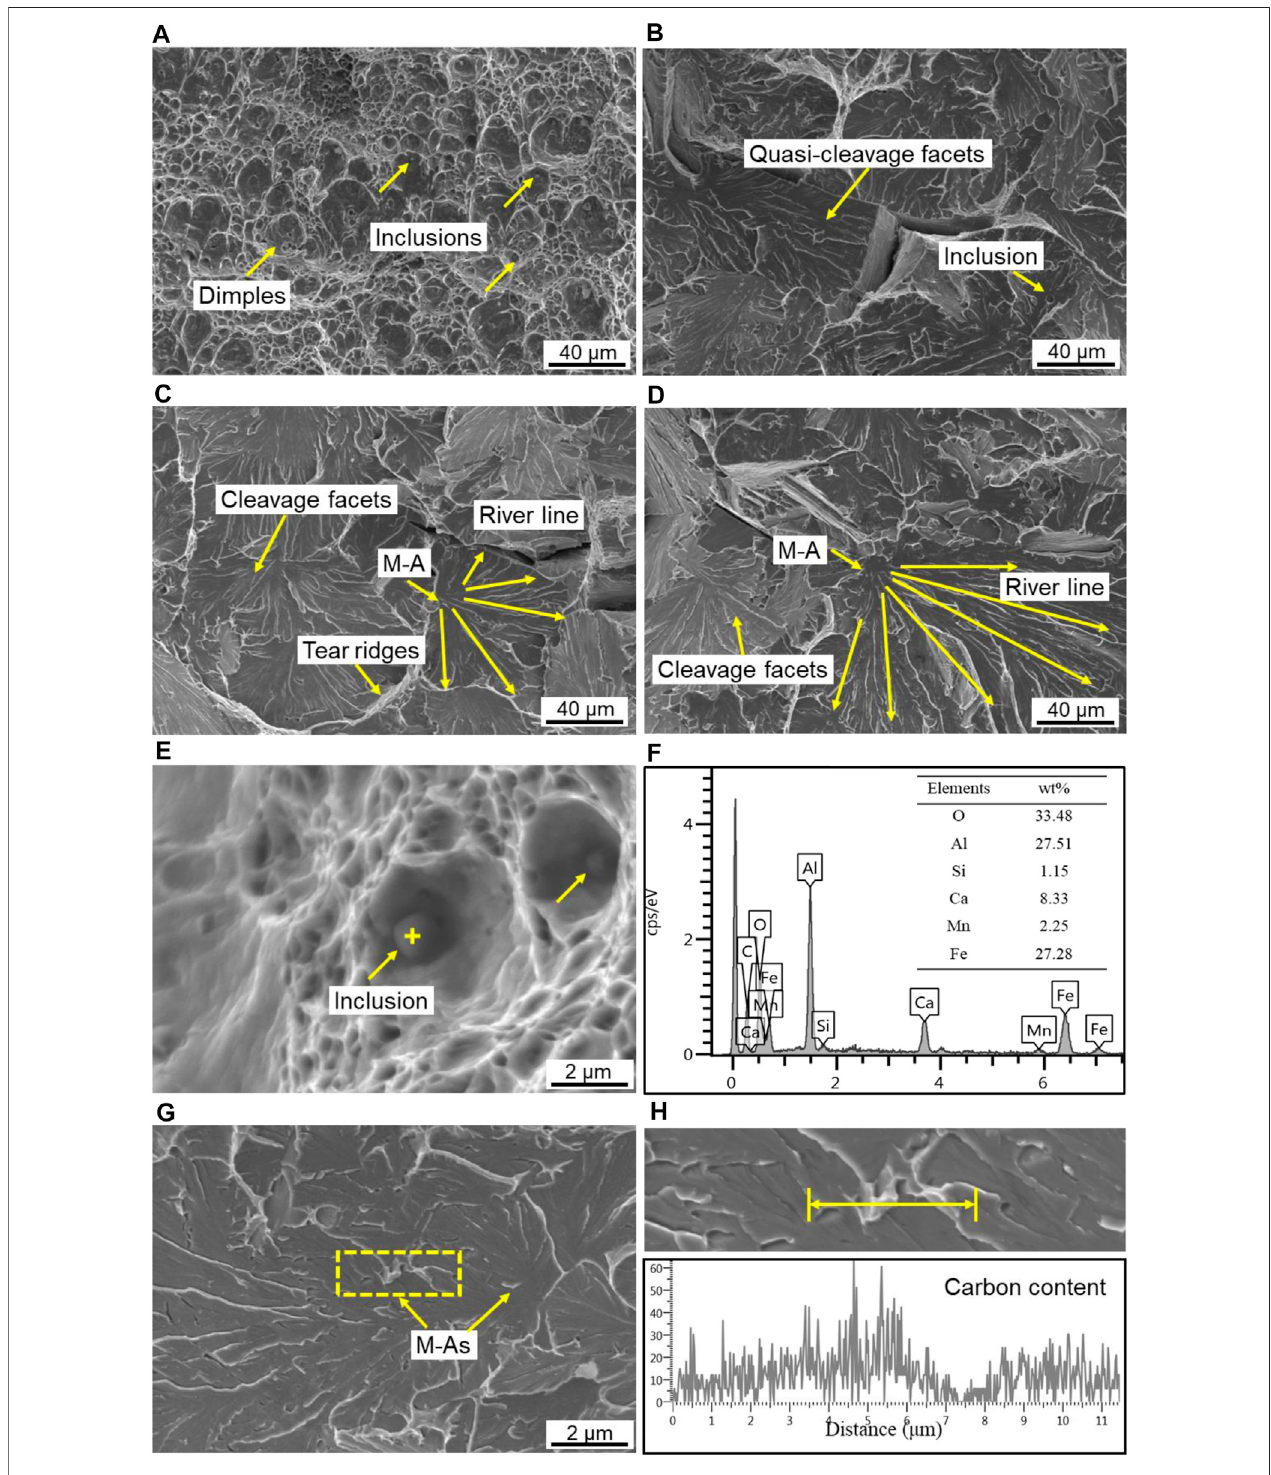
FIGURE 11 | SEM fracture morphologies ofthe fracture surfaces at the heatinputs of (A) 50, (B) 100, (C) 150, and (D) 200 kJ/cm; the inclusions in the tear ridges (E, F) ; and the fracture initiation site (G, H) at the heat input of 100 kJ/cm.